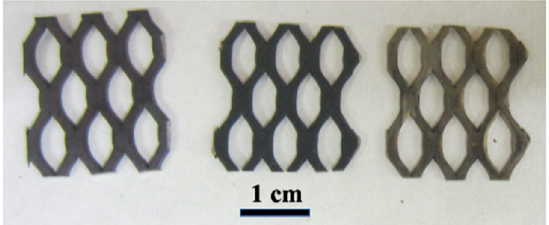
Figure 2. Various anode electrodes compared. From left to right: RuO 2 nanorod-decorated MMO ribbon mesh anode, Ir/Ta MMO ribbon mesh anode, and Ti ribbon mesh anode .